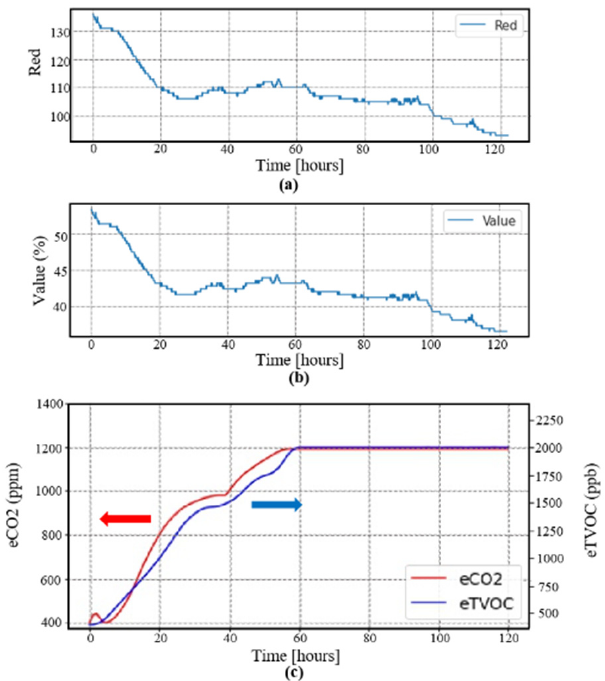
Figure 11. Pa tt ern of change against the time through the measured sensor values; ( a ) red value, ( b ) Value value, ( c ) eTVOC value, and eCO 2 value.